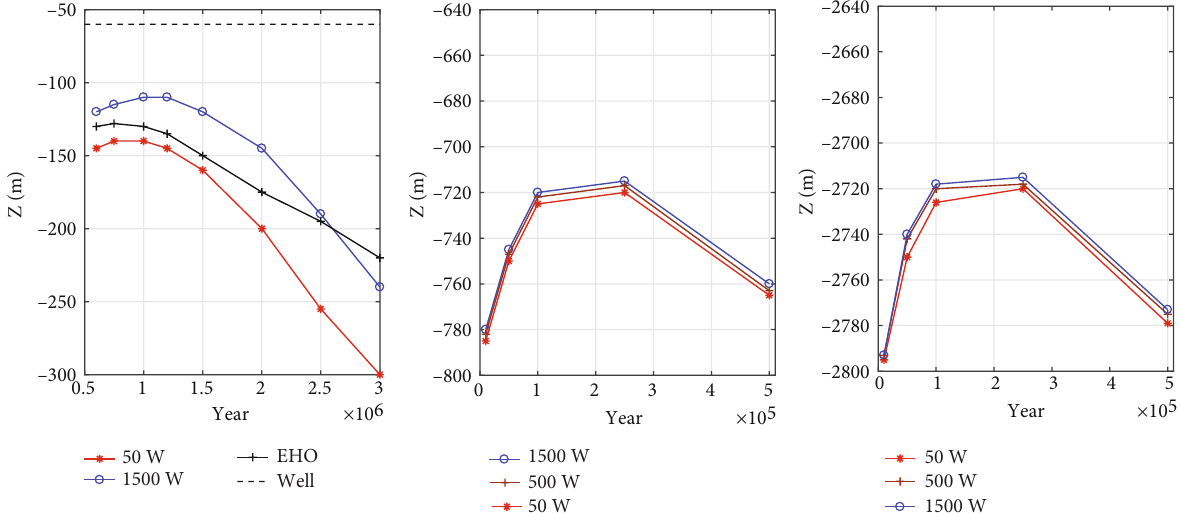
Figure 15: Depths at which the annual dose has decreased to 0.01mSv/y (dose above each line < 0.01mS/y). (a) D = 5 × 10 − 10 m 2 /s , 0.5km disposal borehole and k = 10 − 16 m 2 . (b) 1km disposal borehole and k = 10 − 16 m 2 . (c) 3 km disposal borehole and k = 10 − 16 m 2